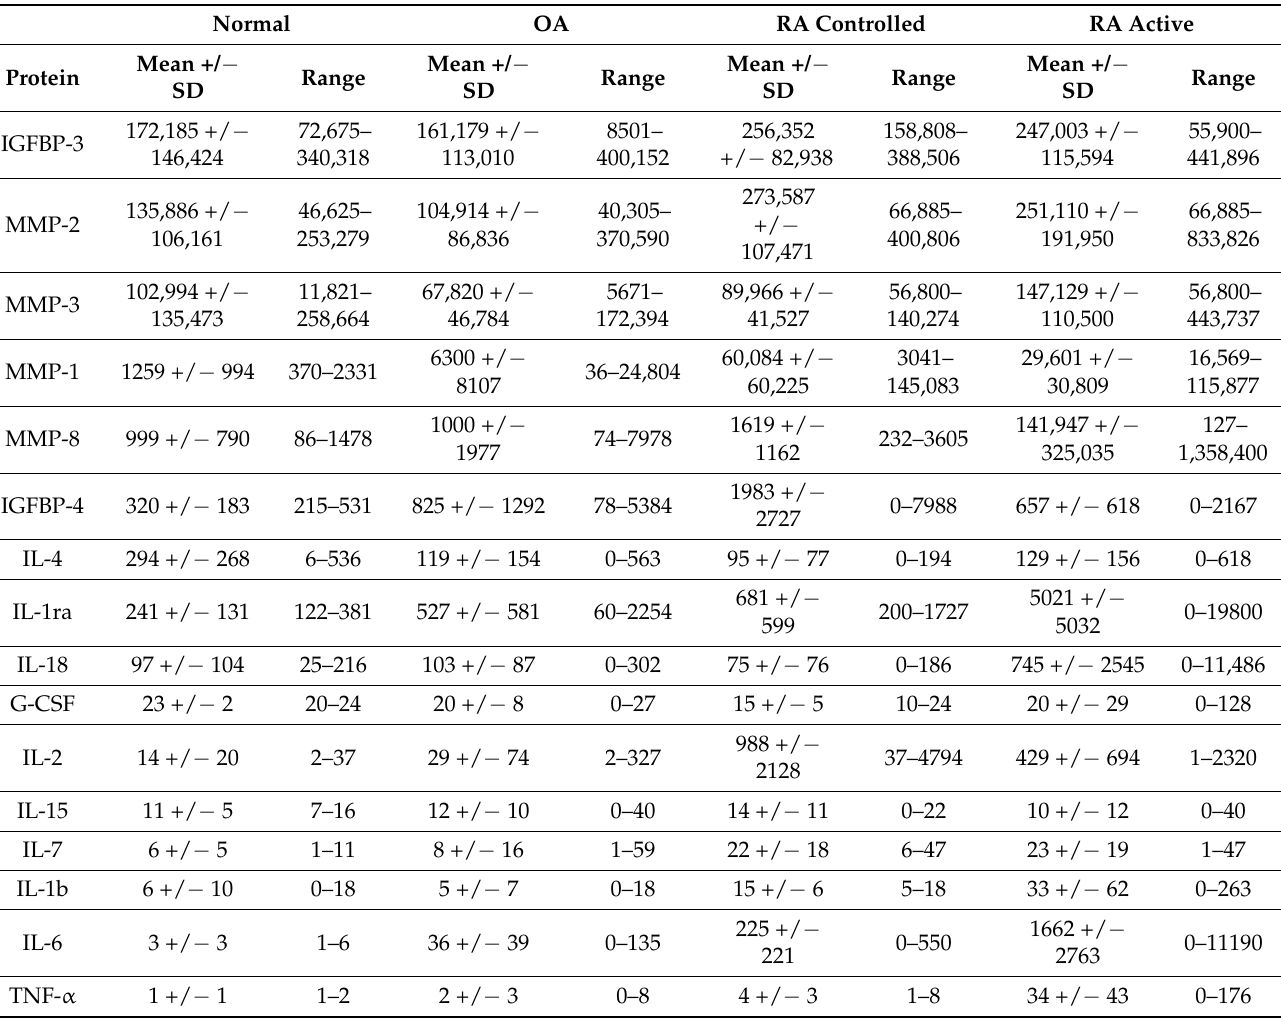
Table 2. Displays the mean values, standard deviation and range for each analyte in pg/mL for normal subjects, patients with osteoarthritis, compared to patients with controlled rheumatoid arthritis and active rheumatoid